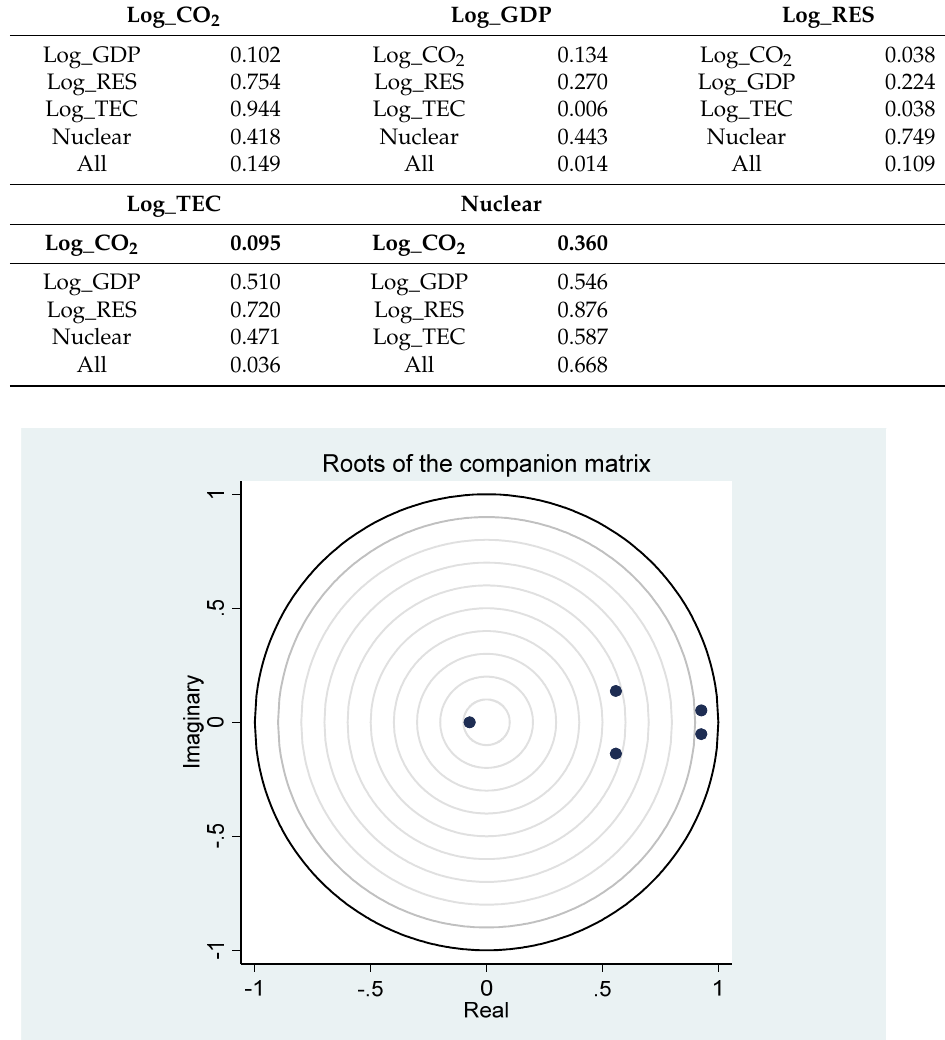
Figure 2. Roots of the companion matrix.